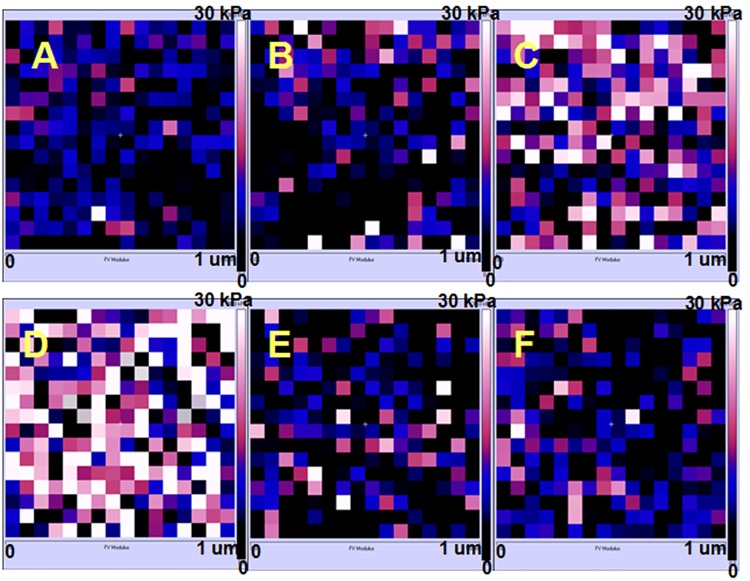
ROS scavenger-NAC reversed oridonin induced changes of Young’s modulus in oesophageal cancer KYSE-150 cells.Typical Young’s modulus maps obtained from (A) control, (B) 10 μM oridonin treated, (C) 30 μM oridonin treated, (D) 50 μM oridonin treated, (E) 2.5 mM NAC+50 μM oridonin treated and (F) 2.5mM NAC treated KYSE-150 cells.